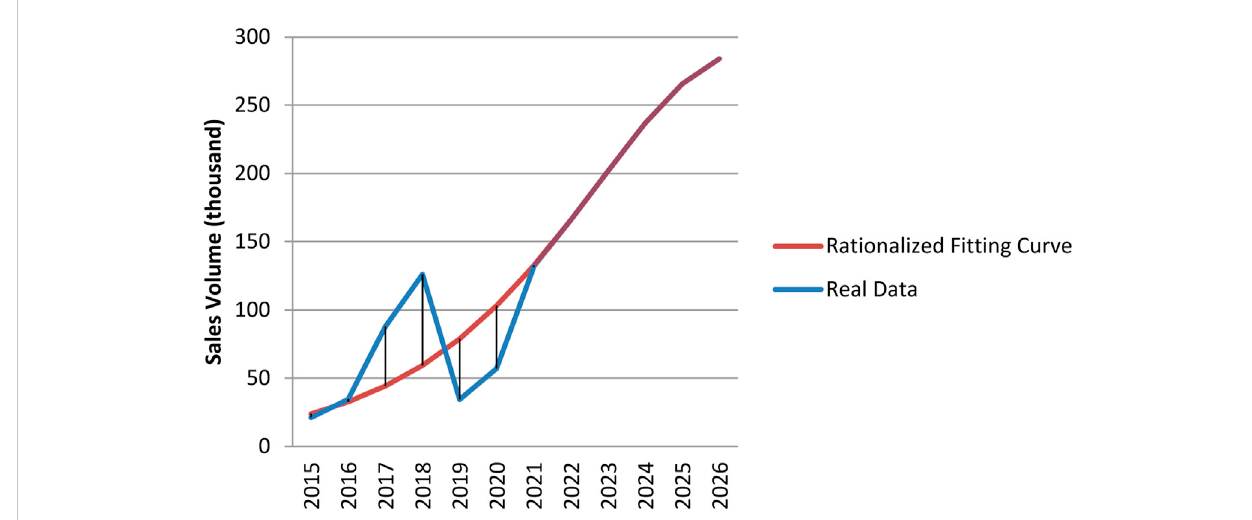
FIGURE 1 Sales trend of electric vehicles in urban logistics in the Chinese market.